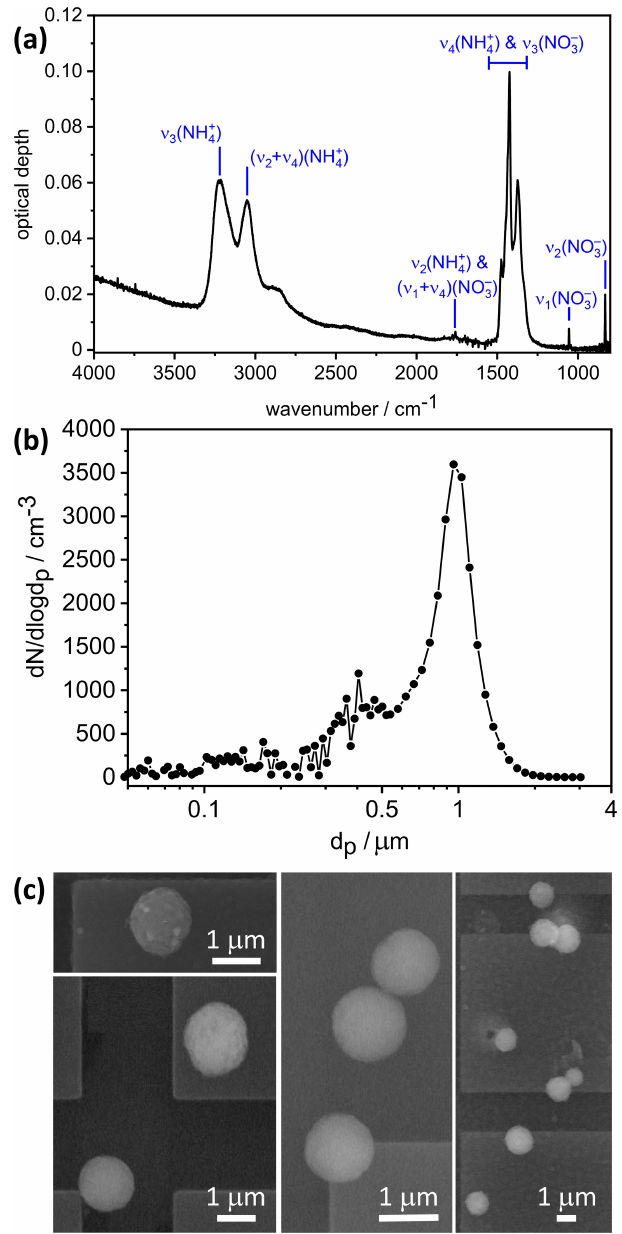
Figure 2. (a) Infrared extinction spectrum of crystalline AN parti- cles recorded at 223K. The notation of the AN vibrational modes is according to Fernandes et al. (1979). (b) Concomitant number size distribution of the almost pure AN particles crystallized from solution droplets with 99.4mol% AN and 0.6mol% AS. The data are shown as a function of the equal-volume sphere diameter, d p , as obtained by converting the mobility and aerodynamic size spectra from the SMPS and APS measurements with ρ( AN ) = 1 . 72gcm − 3 and χ = 1 . 1. (c) Exemplary electron microscope images of filter- sampled, continuously cooled AN crystals from a crystallization ex- periment with 97.1mol% AN and 2.9mol% AS.